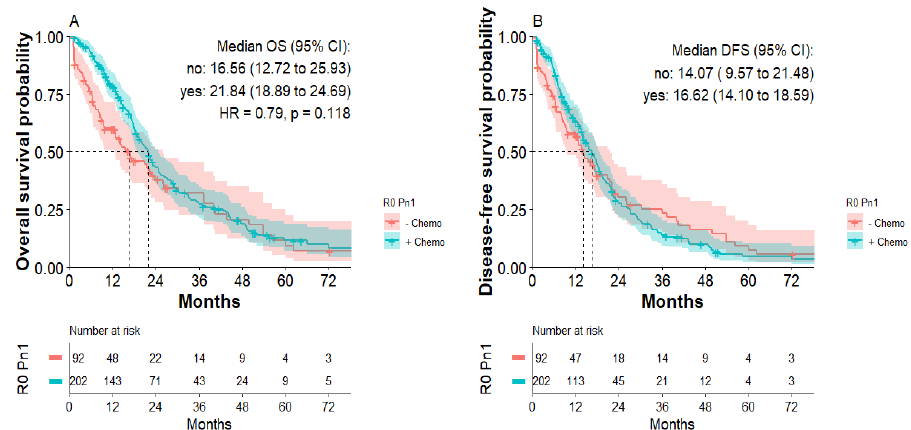
Figure 4. Overall survival and disease-free survival of patients with R0 Pn1 tumors with or without postoperative chemotherapy. ( A ) Overall survival of patients with R0 Pn1 tumors with or without postoperative chemotherapy. ( B ) Disease-free survival of patients with R0 Pn1 tumors with or without postoperative chemotherapy.